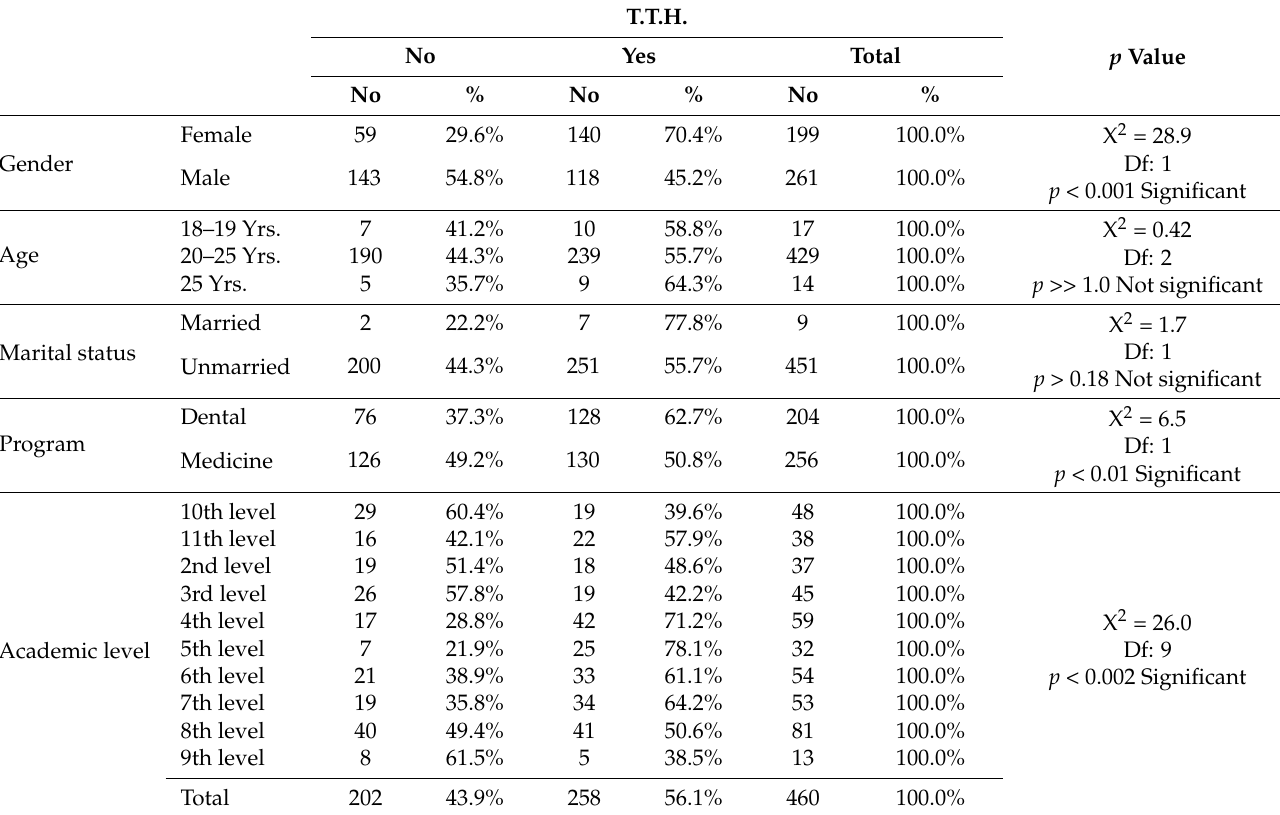
Table 2. Distribution of subjects based on demographic profile and T.T.H.